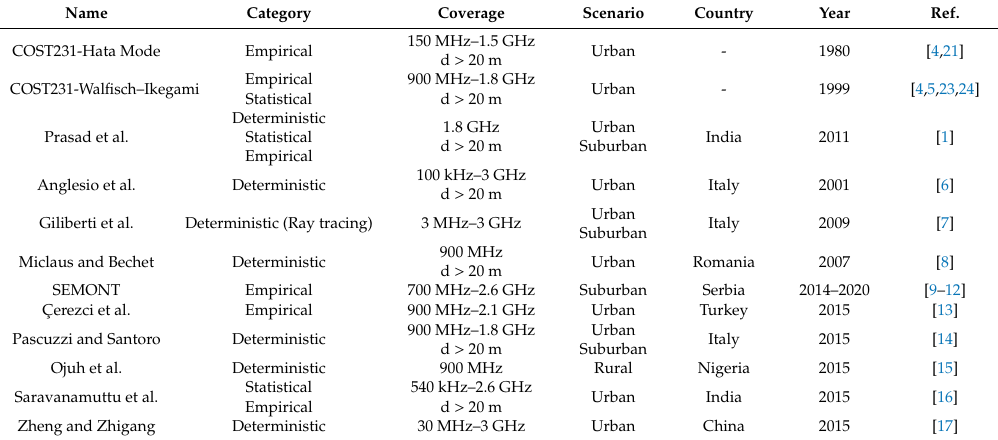
Table 1. Summary table of the state-of-the-art of propagation models and field level